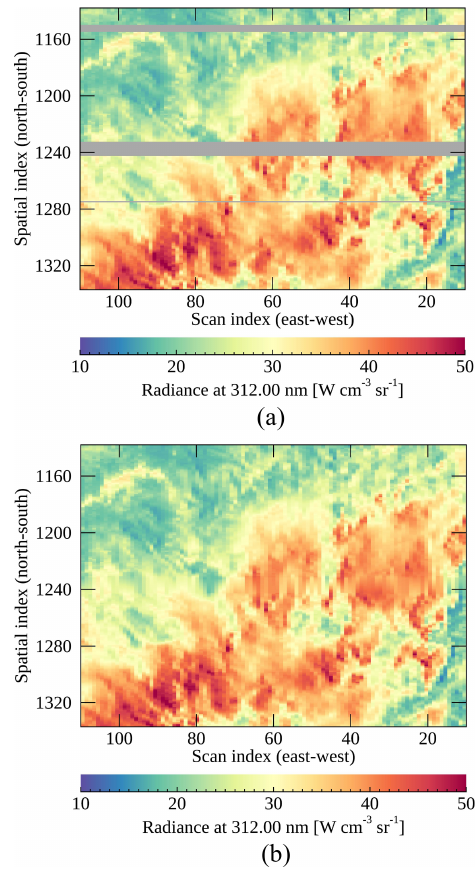
Figure 2. Spatial distribution of GEMS radiances at 312nm with bad pixels (a) marked in dark gray and (b) reproduced with spatial interpolation. The GEMS spectra were measured on 10 March 2021